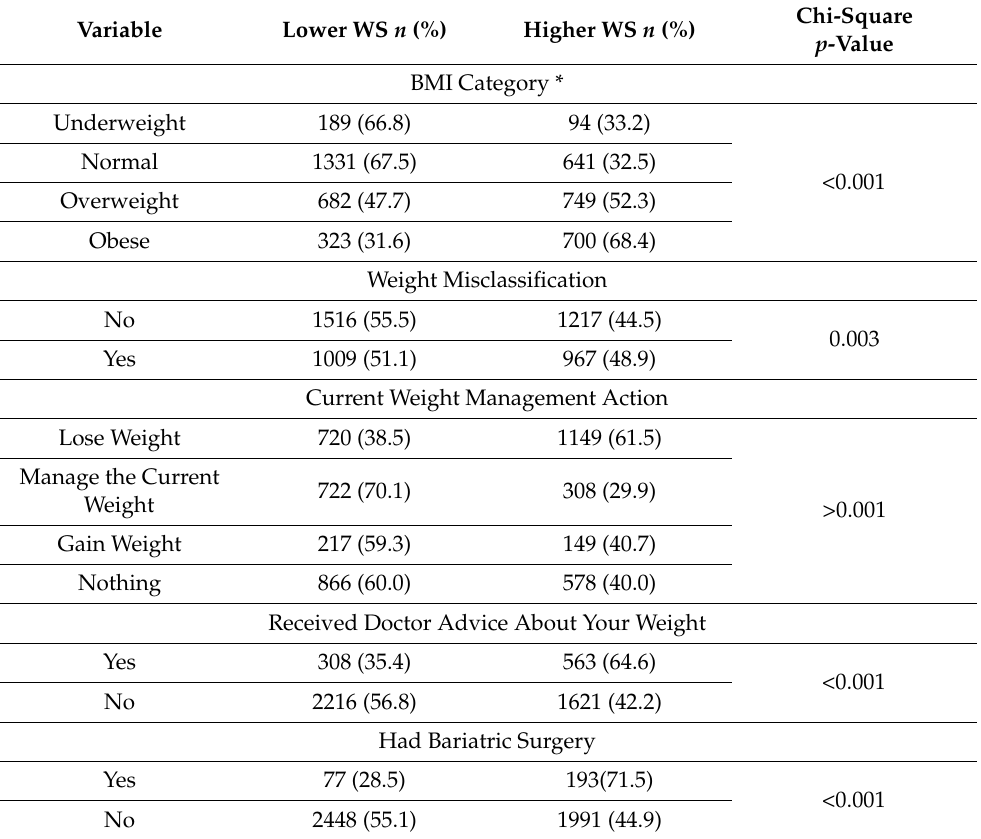
Table 4. Associations between WS and weight management-related variables ( n = 4709).